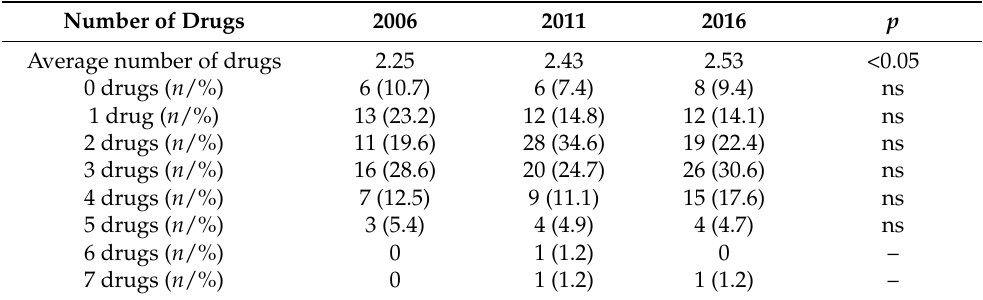
Table 3. The number of antihypertensive drugs used in the study population.